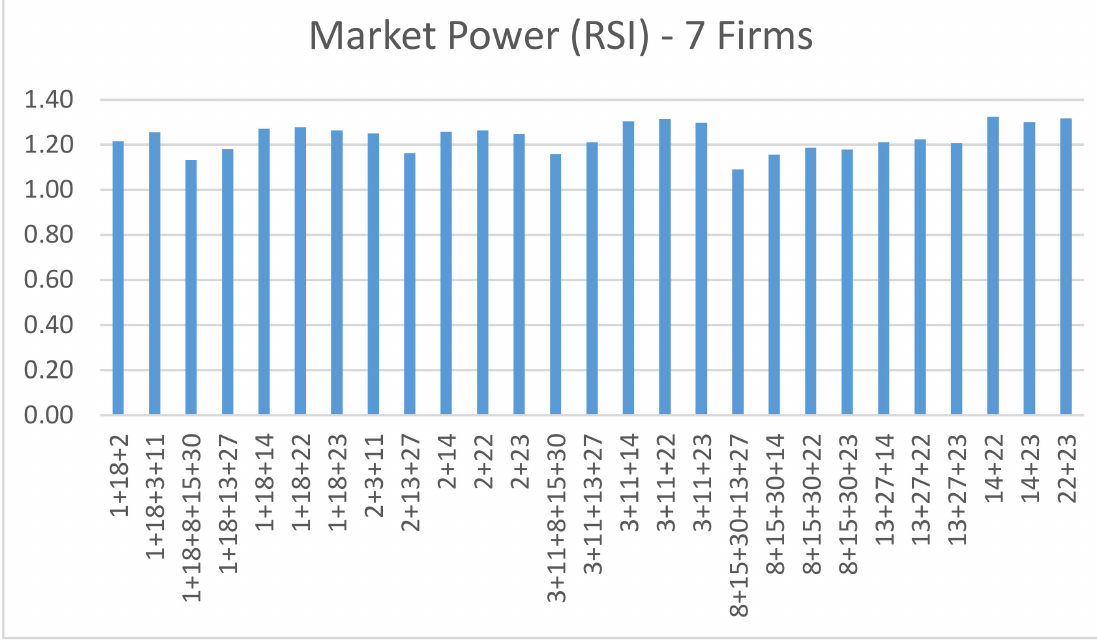
Figure 10. RSI for 7 firms’ setting